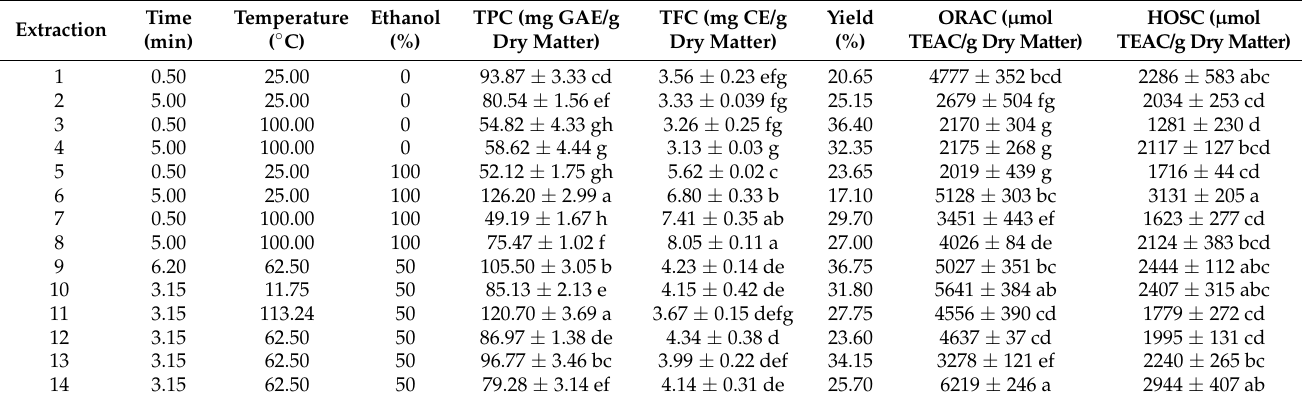
Table 2. Empirical results of total phenolic content (TPC), total flavonoid content (TFC), yield, and ORAC and HOSC assays for the microwave-assisted extraction of bioactive compounds from saffron floral-by products 1